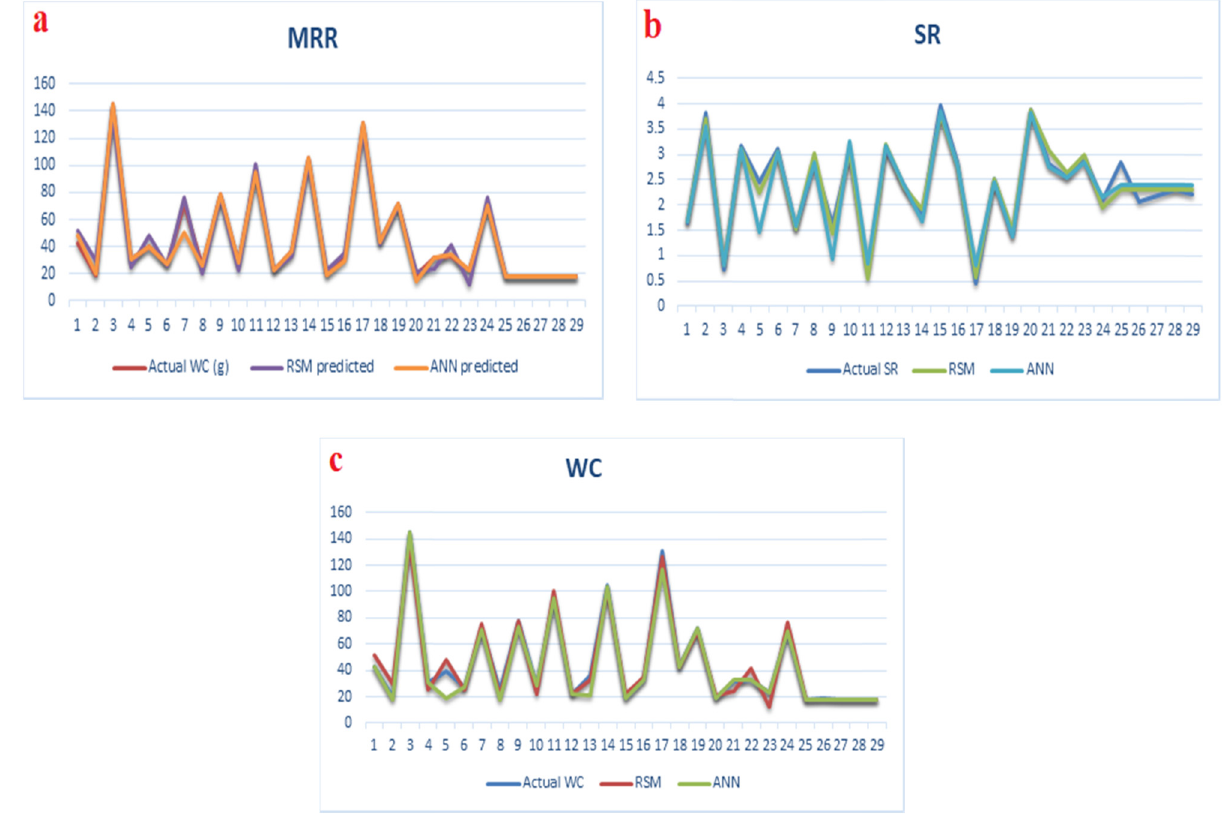
Figure 6: Relative graph of actual vs predicted values for ( a ) MRR, ( b ) SR, and ( c )